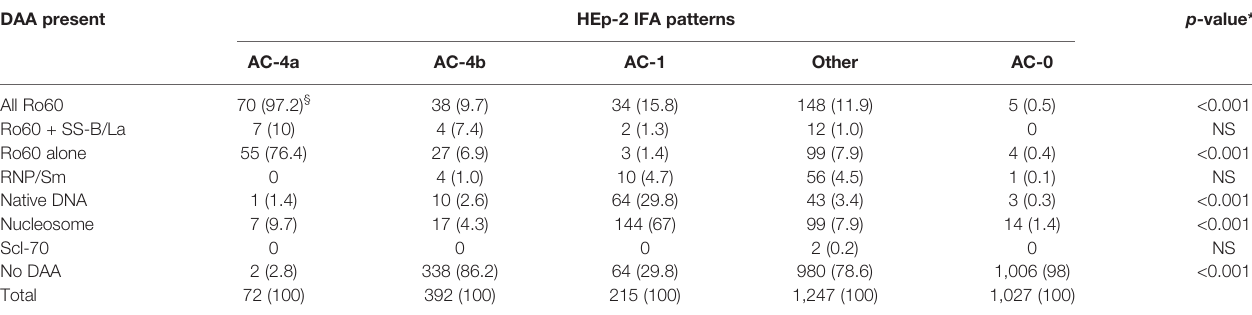
*All samples were tested for the following disease-associated autoantibodies (DAA): Ro60, SS-B/La, Sm, U1-RNP, Scl-70, native DNA, and nucleosome. **The statistics compared the frequency of patterns in samples with a given autoantibody vs. all the other samples negative for that autoantibody. § Percentages represent the frequency of any given autoantibody speci fi city in relation to the total of samples with the respective pattern. NS, non-signi fi cant.